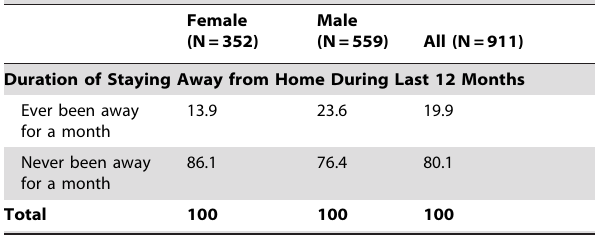
Table 1. Characteristics of fishing community members age 15–59 years (N= 911).